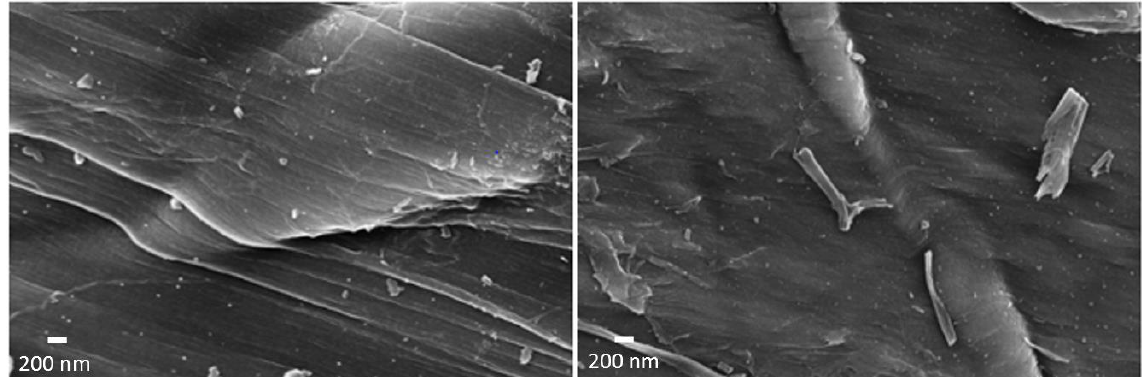
Figure 4. On the left is the hard carbon coming from the apricot kernel before the activation with KOH. On the right, the same carbon is shown after the activation treatment.